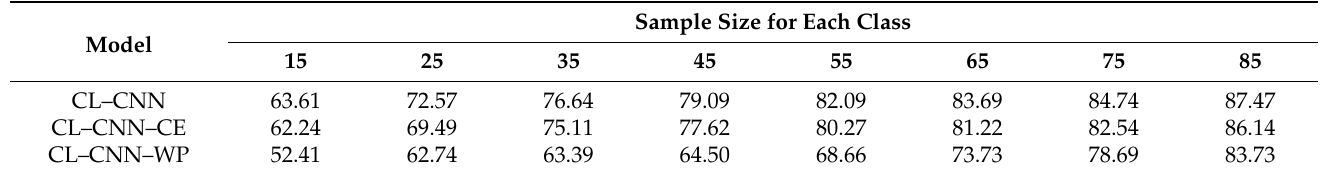
Table 8. Classification performance of the CL–CNN, CL–CNN–CE and CL–CNN–WP models at − 5 dB SNR.